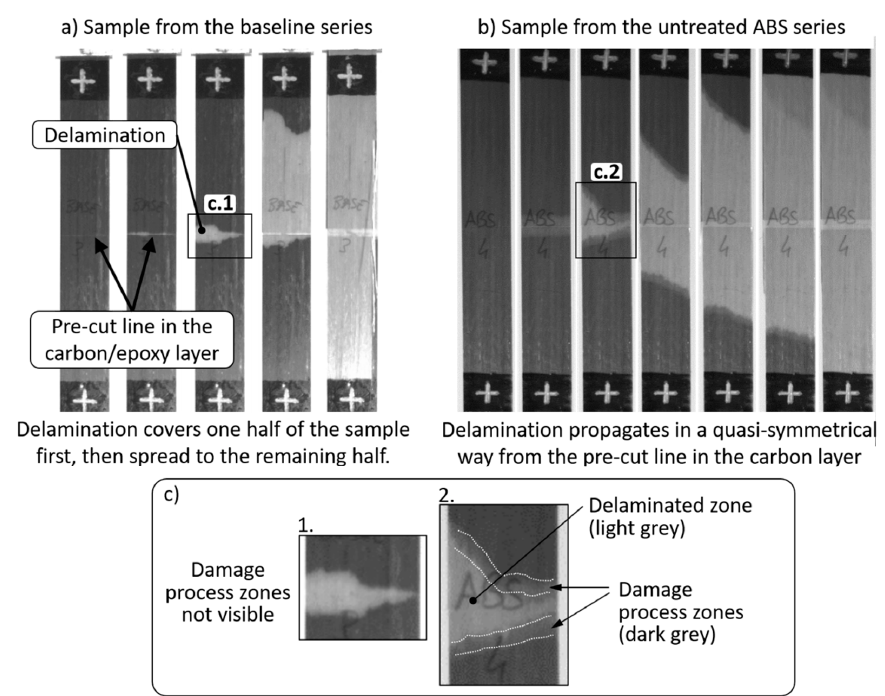
Figure 8. Comparison between the delamination patterns of samples from the ( a ) baseline and the ( b ) untreated ABS series . Part ( c ) shows magnified images of the pre-cut regions where delamination initiates from.